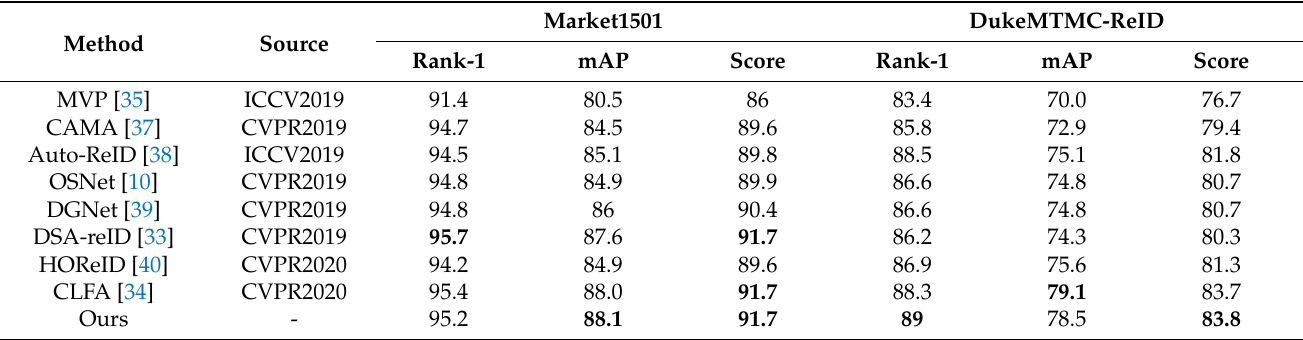
Table 3. Comparison of different methods on Market1501 and DukeMTMC-ReID.